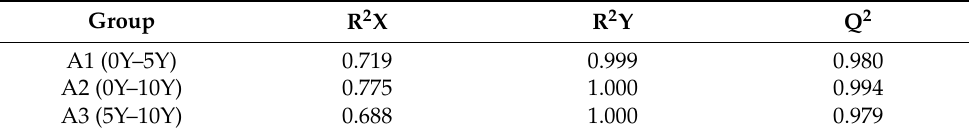
Table 2. Parameters of the OPLS-DA models for the industrially fermented kohlrabi